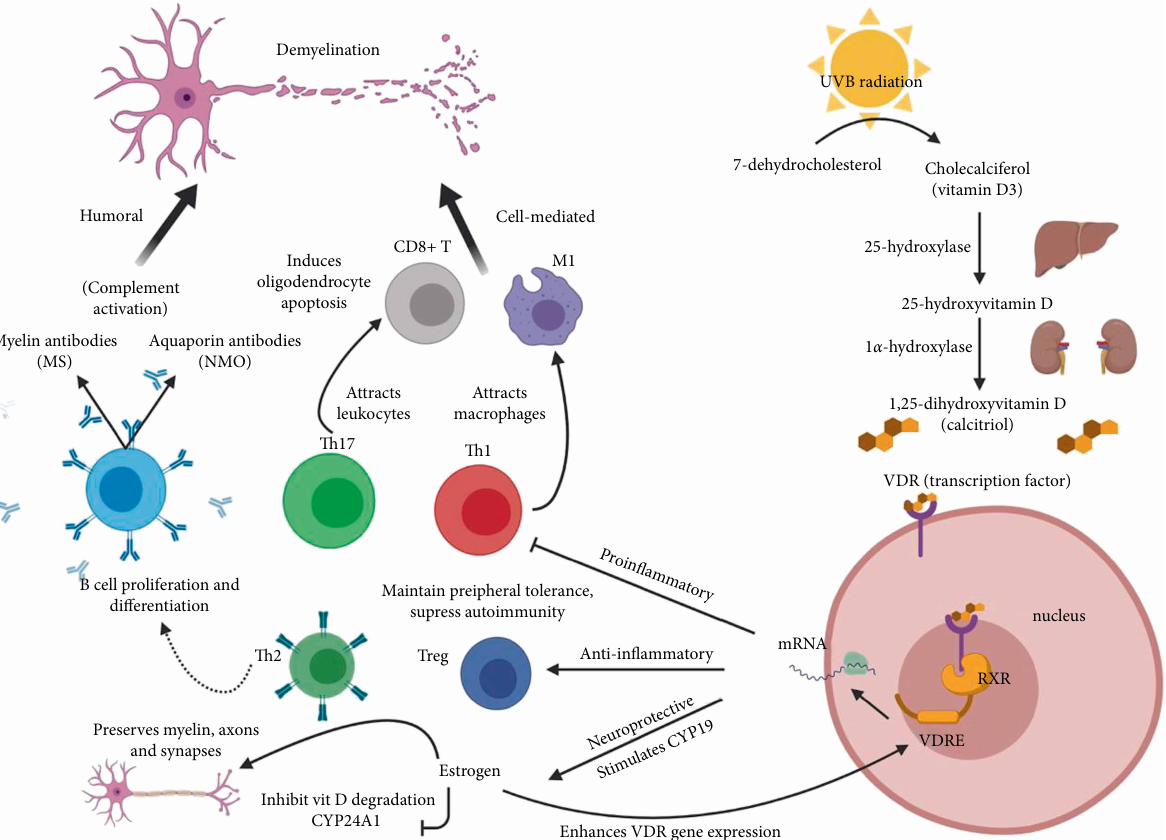
Figure 1: A roadmap of vitamin D production and putative roles in autoimmune demyelinating disease. Once activated to calcitriol by liver 25-hydroxylases and kidney 1 α -hydroxylases, vitamin D can execute a variety of immunologic functions. Calcitriol binds the VDR receptor which acts as a transcription factor when complexed with nuclear retinoid X receptor. The VDR-RXR heterodimer then binds to DNA sequences within gene promoter regions (vitamin D response elements) and facilitates the expression of gene products which may be classified as neuroprotective, anti-inflammatory, and proinflammatory. Vitamin D increases estrogen production (stimulation of aromatase (CYP19) converts testosterone to estrogen). Estrogen preserves vital components of the CNS attacked in autoimmune disease and regulates vitamin D production (inhibits degradation by 24-hydroxylase (CYP24A1). Vitamin D suppresses autoimmunity by promotion of anti-inflammatory T cell subsets: T helper 2 (Th2) and regulatory T (Treg) cells. Vitamin D downregulation of proinflammatory cytokines IL-1 and IL-21 (not depicted) and T cell subsets: T helper 1 (Th1) and 17 (Th17) prevents macrophages and other leukocytes from exerting cell mediated toxic effects on myelin. B cell proliferation and antibody production are also inhibited, knocking out the key mediators of humoral mediated demyelinating damage. Th2 cells are pathologically involved in the induction of B cells producing self-antibodies in MS, but a higher ratio of Th2 to Th1 is associated with reduced inflammation. M1 macrophages release proinflammatory cytokines, metalloproteases and free radicals and carry out phagocytosis of myelin (early stage of MS) that leads to CNS destruction while M2 macrophages repair inflammatory damage (late stage of MS). In NMO, macrophages may scavenge the byproducts of astrocyte cytotoxicity and eosinophil/neutrophil infiltration (not depicted). Created with